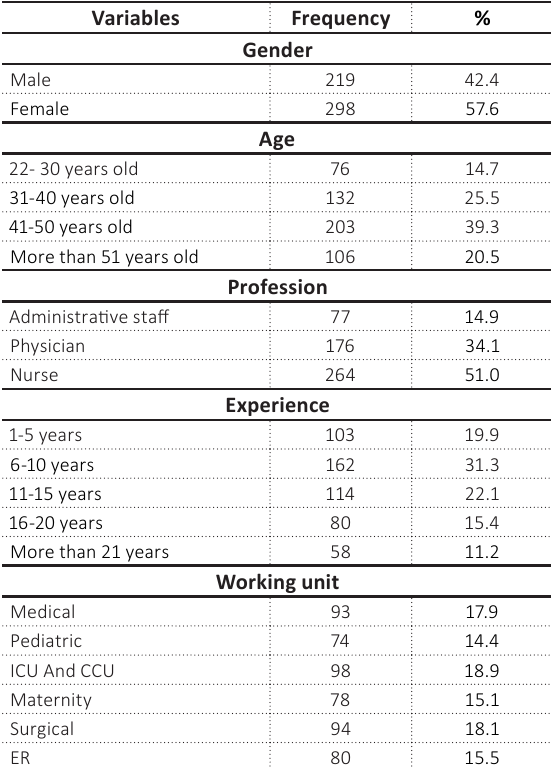
Table 1. Respondents’ demographic profile